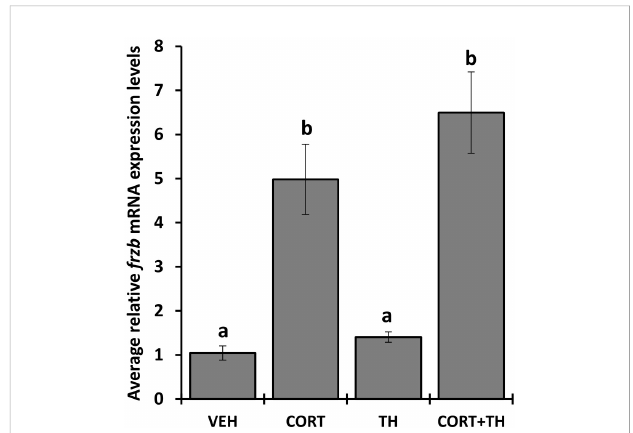
FIGURE 2 Hormone induction speci fi city of frzb in tadpole tails. Premetamorphic tadpoles (NF 54) were treated with vehicle, 100 nM CORT (corticosterone), 10 nM T3 (triiodothyronine), and CORT+T3 for 24 h. Tails were dissected, followed by RNA extraction and quantitative PCR for frzb and the housekeeping gene rpl8 . Bars represent mean mRNA levels relative to rpl8 and normalized to a vehicle control sample. n = 10 tail samples per treatment. Error bars represent SE. Letters indicate signi fi cant groups, p < 0.05.